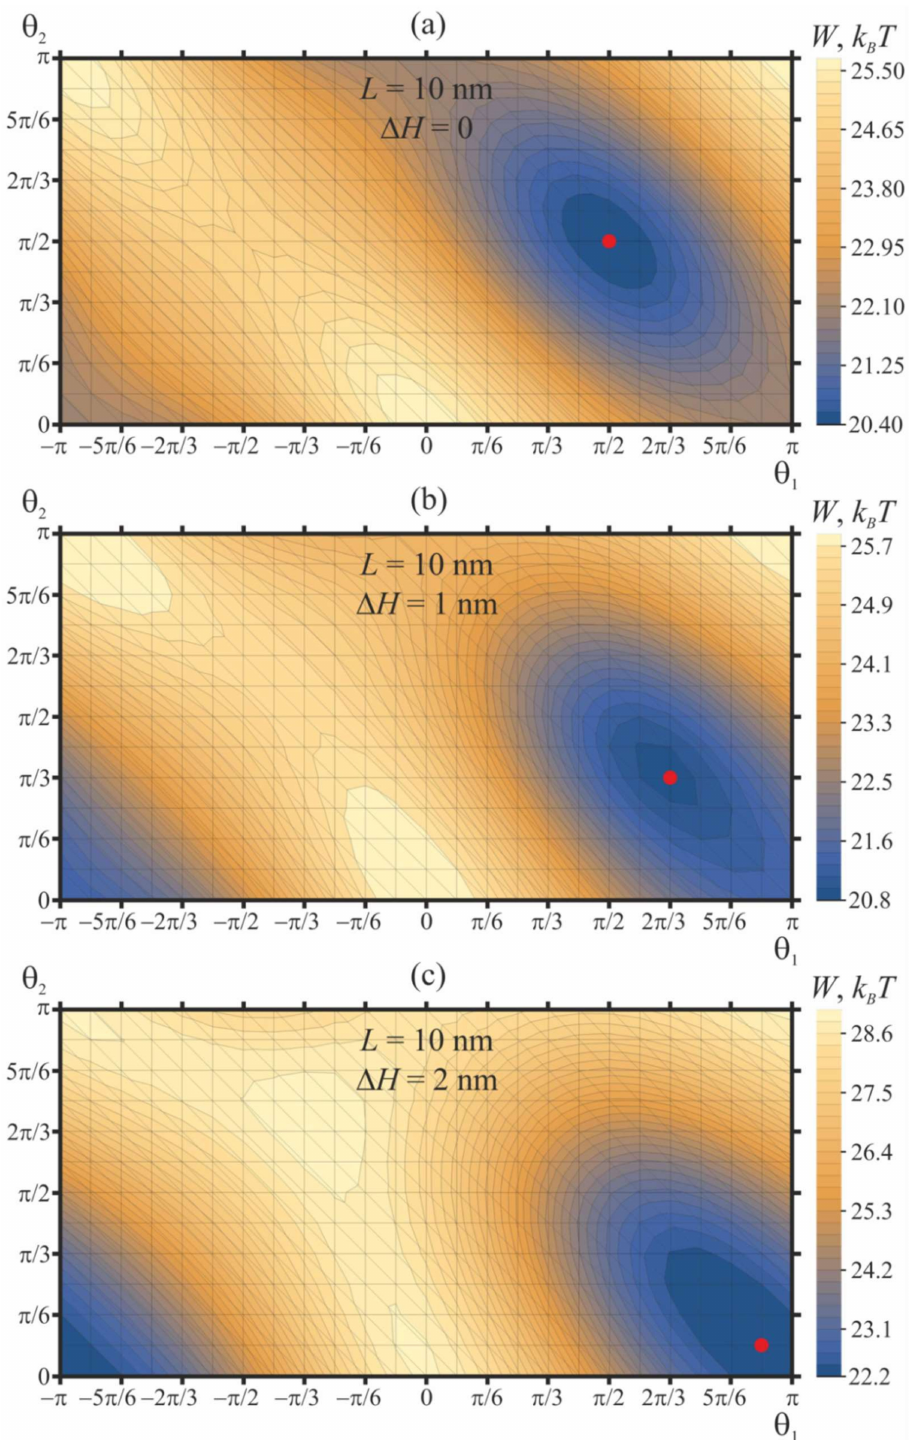
Figure 6. Dependence of membrane elastic energy on the orientation angles of two pulled peptide trimers, whose vertical positions are fixed at ( a ) ∆ H = 0; ( b ) ∆ H = 1 nm; ( c ) ∆ H = 2 nm. The minima of the elastic energy (marked by the red circle) are at ( a ) θ 1 = θ 2 = π / 2 for ∆ H = 0; ( b ) θ 1 = 2 π / 3, θ 2 = π / 3 for ∆ H = 1 nm; ( c ) θ 1 = 11 π / 12, θ 2 = π / 12 for ∆ H = 2 nm. The minima shifts toward the symmetric configuration of θ 1 = π , θ 2 = 0 as ∆ H